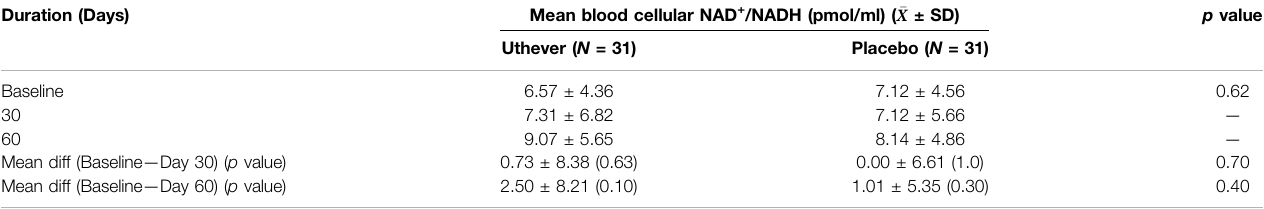
TABLE 2 | Comparison of changes in mean blood cellular NAD + /NADH between the groups. Duration (Days)